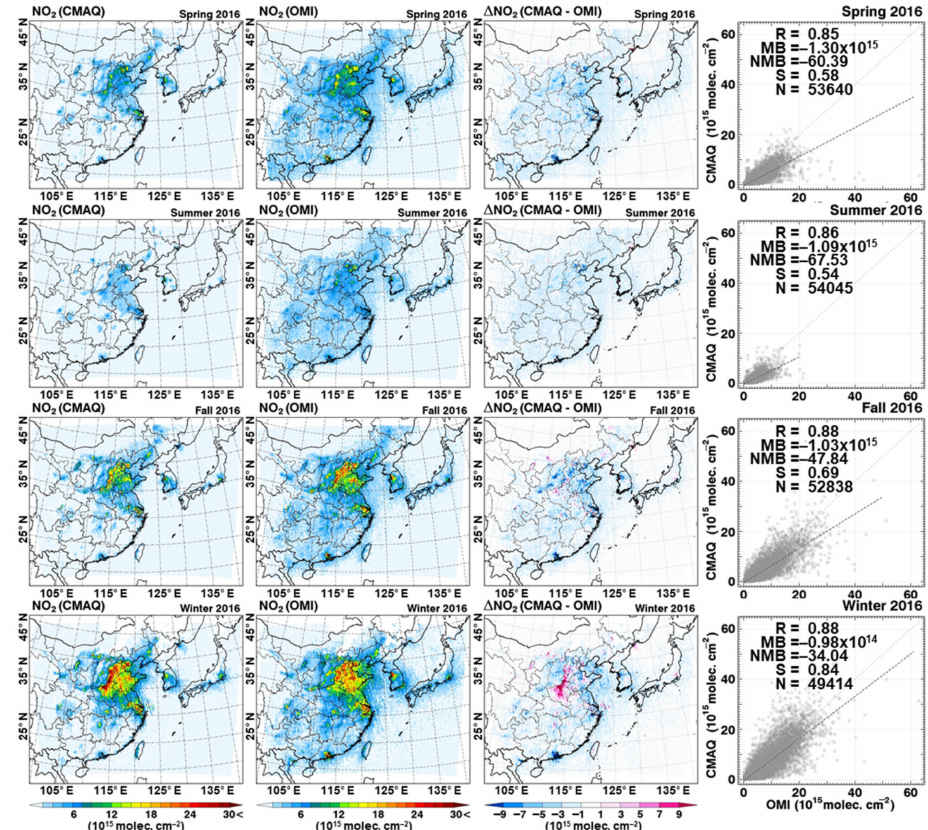
Figure 7. Spatial distributions of CMAQ-simulated and OMI-retrieved tropospheric NO 2 in the first and second columns. Their differences and scatter plots between two columnar NO 2 in third and fourth columns, respectively. In statistical analysis, R, MB, NMB, S, and N represent correlation coefficient, mean bias (molecules cm − 2 ), normalized mean bias (%), slope, and the number of data, respectively.